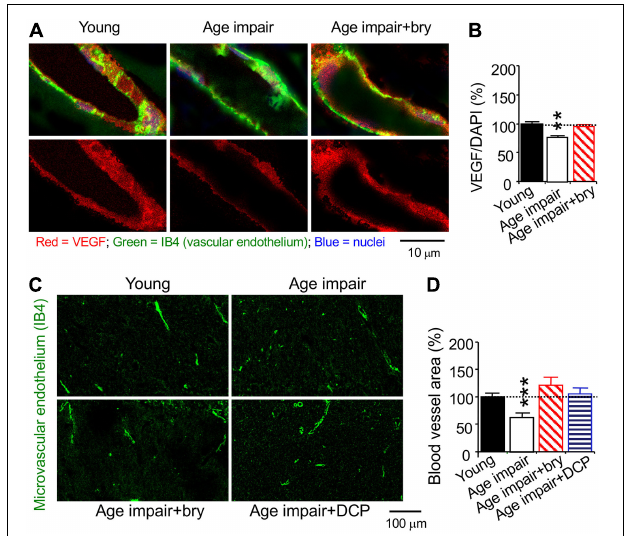
FIGURE 6 | The PKC ε activator prevents a decrease in vascular VEGF and MV loss in the CA1 hippocampal stratum radiatum from age-related memory impairment rats. Tissue sections from rats in Figure 5 were used to stained with cytochemistry of the vascular endothelial cell marker IB4. (A) Colocalization of histochemistry of the vascular endothelium marker IB4 and (B) immunohistochemistry VEGF levels. (C) Low magnification of confocal microscope of the vascular endothelium marker IB4 was used to determine (D ). MV density in random hippocampal CA1 areas. Data are presented as mean ± SEM; ** p < 0.01, *** p < 0.001; one-way ANOVA and post hoc Tukey’s multiple comparison test ( n = 63–95 random MV cells or 32–119 random areas from 3 to 5